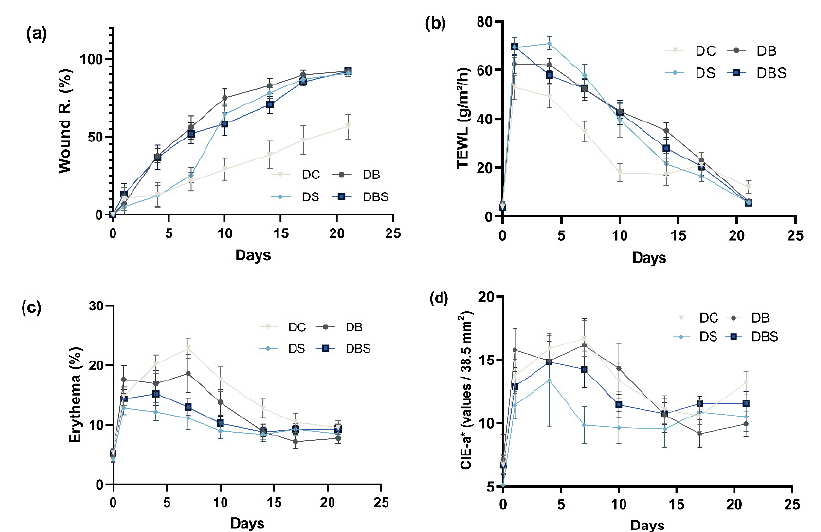
Figure 3. Changes to skin wound surface characteristics during wound healing in BKS.Cg-Dock7m +/+ Leprdb/JNarl mice. Gauze (DC, n = 9), bacterial cellulose (DB, n = 9), Suile ointment (DS, n = 9), and Suile ointment combined with bacterial cellulose (DBS, n = 9) were respectively applied to mouse groups after wounding. The changes in ( a ) Wound R., ( b ) TEWL, ( c ) erythema, and ( d ) CIE-a* values were detected by a skin analyzer on different days. Bars, means of triplicates ± S.D.